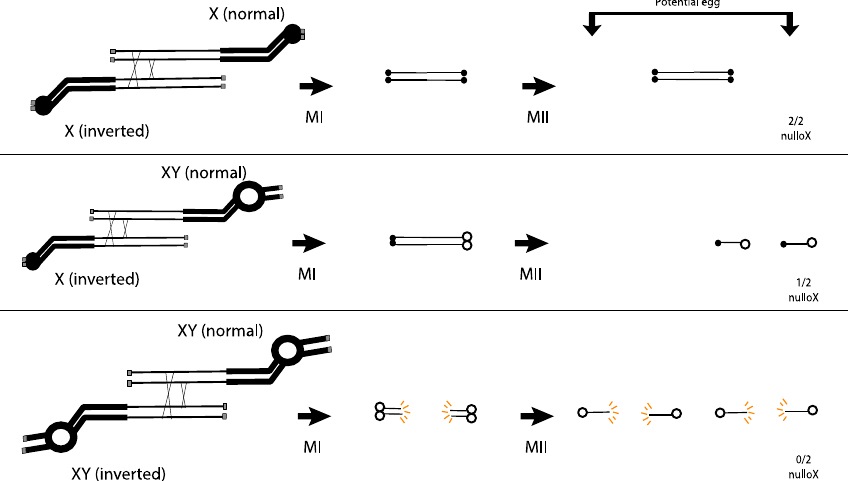
Figure 2. The centromere strength model proposed by Novitski. Only 4-strand DCOs are drawn. Weak ( X ) centromeres are small solid circles, and strong ( Y ) centromeres are large open circles. Grey boxes are telomeres. Acentric products are not shown. Top: Dicentric bridges with two X centromeres do not break in MI or MII, and no X is transmitted. Middle: Dicentric bridges with one X and one Y centromere are dragged during MI and segregate during MII, transmitting a lethal dicentric to 50% of the functional egg nuclei. Bottom: Dicentric bridges with two Y centromeres break in MI, transmitting broken lethal products to the egg nuclei.